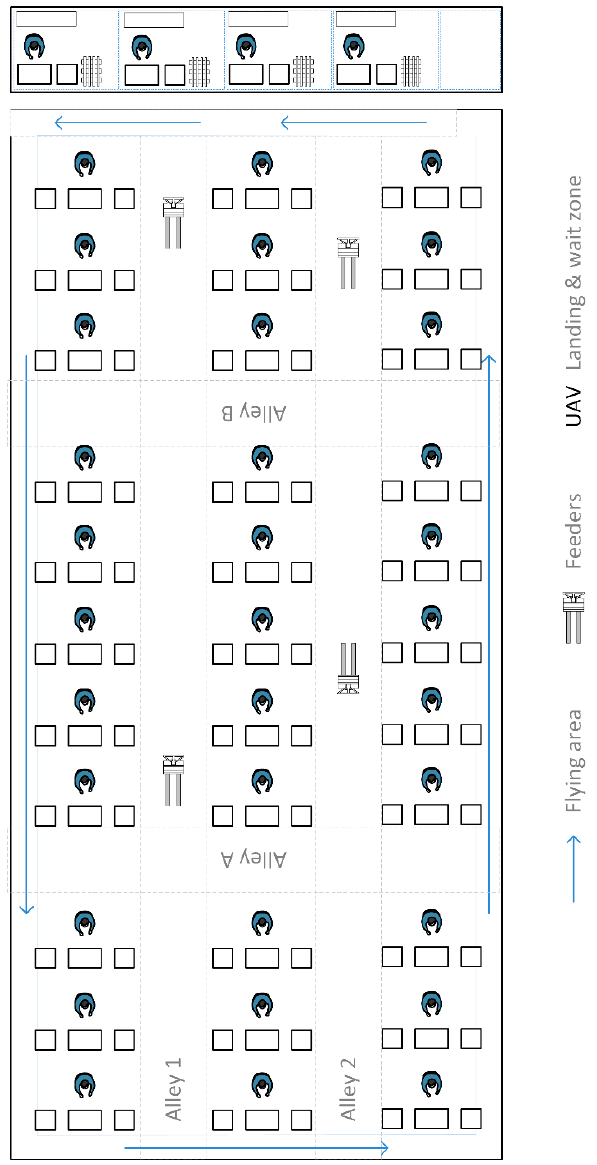
Figure 1. Operator’s workstations at the manufacturing plant used for testing.